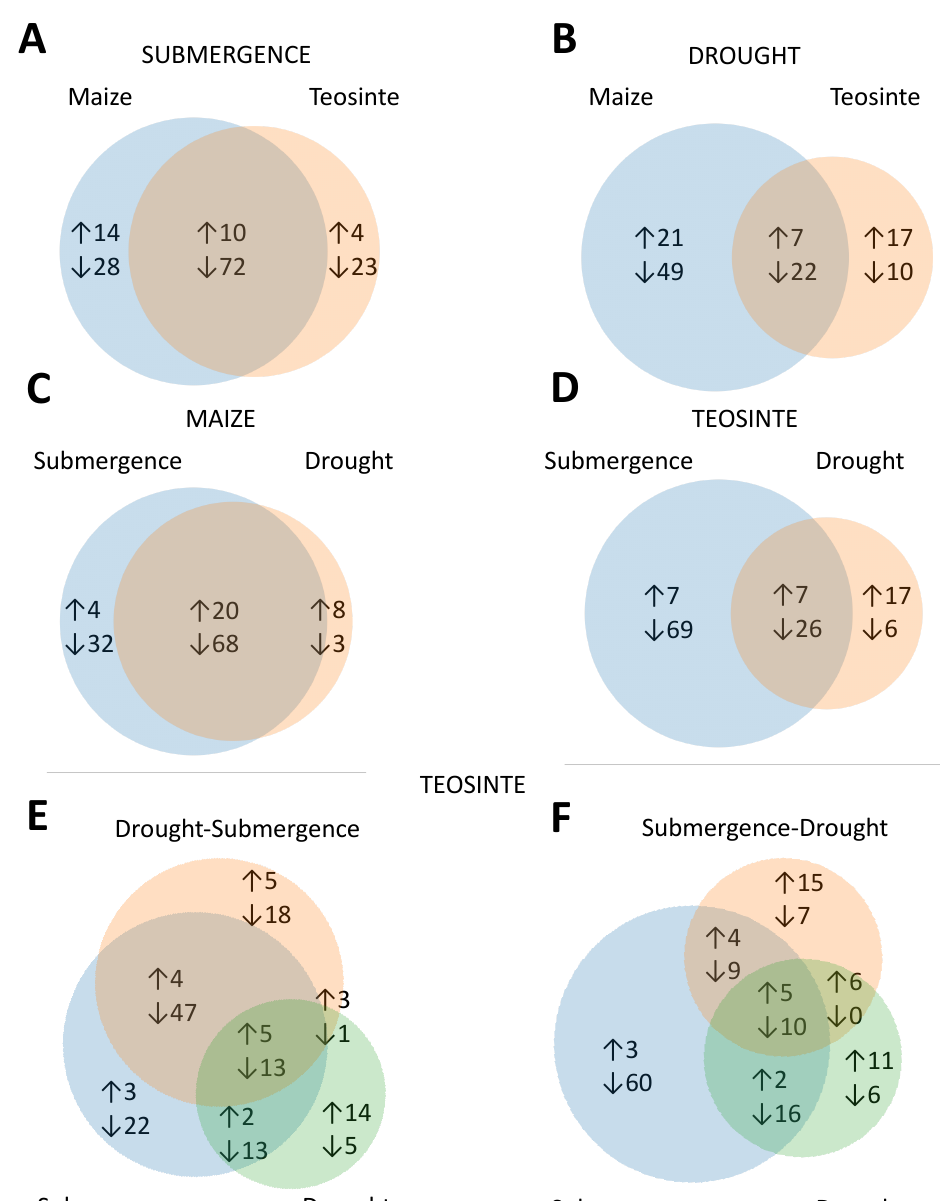
Figure 2. Venn diagrams showing di ff erentially expressed miRNA reads that overlap in maize and teosinteunder( A )submergenceand( B )droughttreatments. PlantmiRNAsoverlappinginsubmergence and drought treatments in ( C ) maize, and ( D ) teosinte. Plant miRNAs overlapping in teosinte under single and alternated treatments of ( E ) drought followed by submergence, and ( F ) submergence followed by drought. Numbers are based on fold change (FC) (log 2 ) values (treatment / control). Upward arrows represent upregulated miRNAs (FC ≥ 1) and downward arrows represent downregulated miRNAs (FC ≤ −